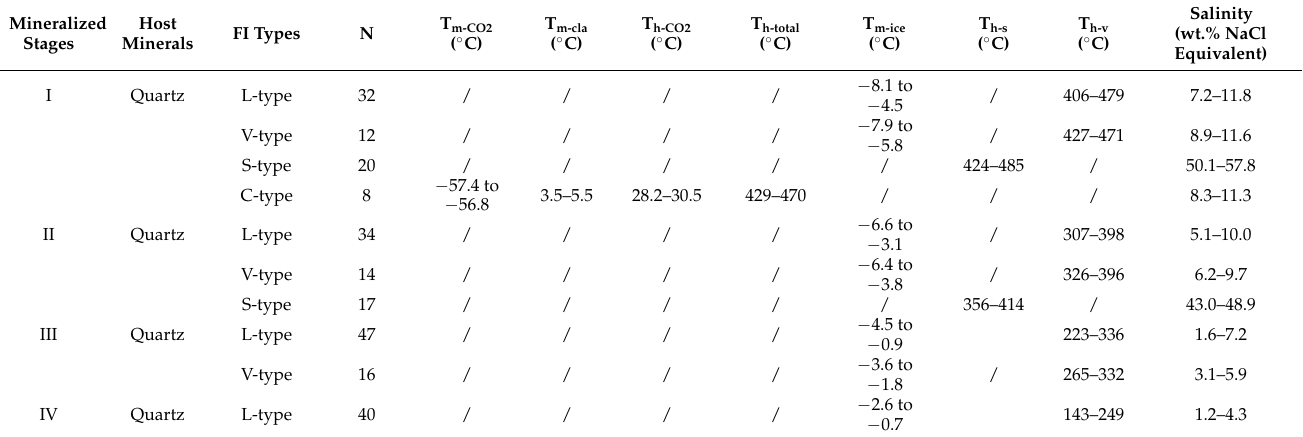
Table 1. Micro-thermometric data and calculated parameters for FIs from the Huoluotai Cu (Mo)